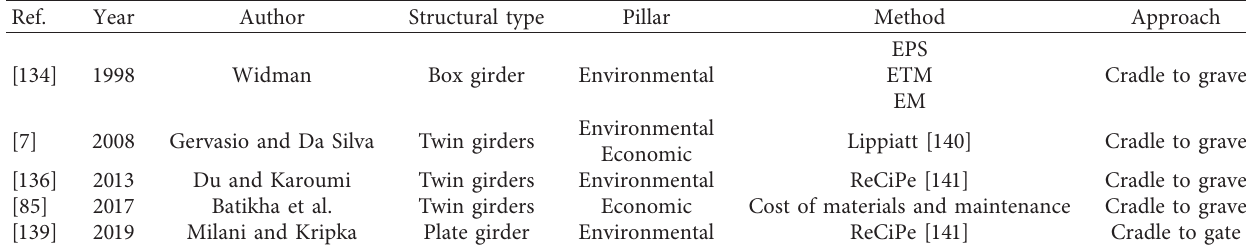
Table 3: Summary of SCCB LCA